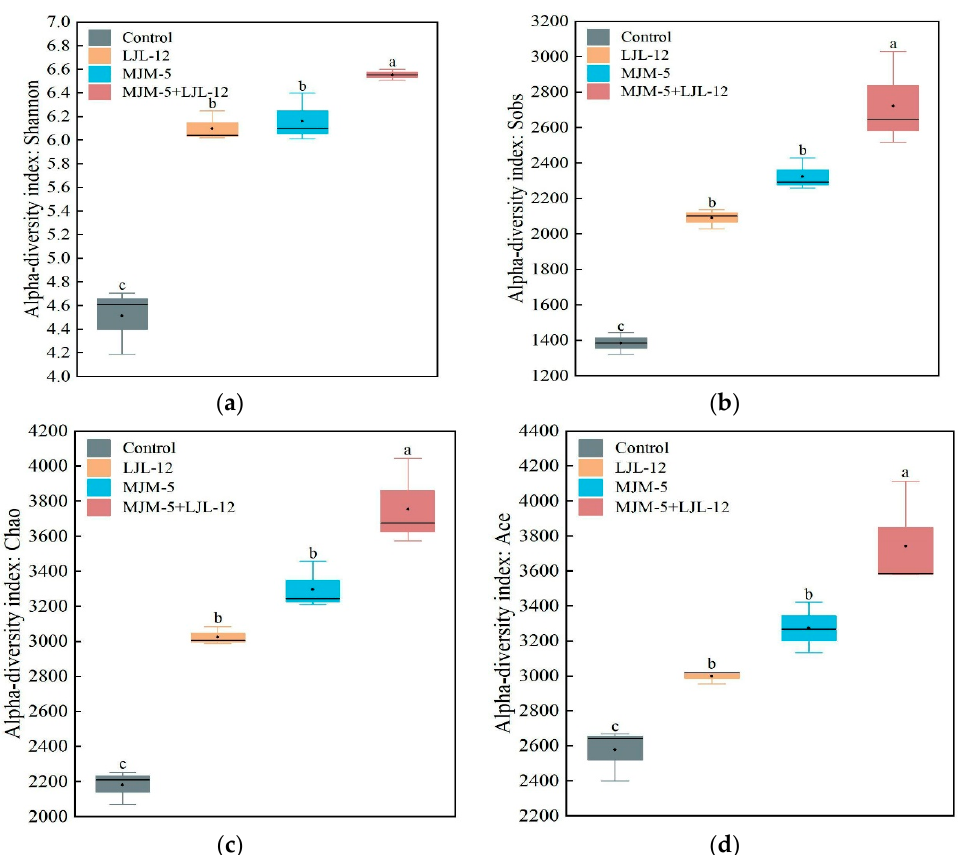
Figure 3. Alpha-diversity indices of soil bacterial community in the rhizosphere of alfalfa under Control, LJL-12, MJM-5, and MJM-5+LJL-12 treatments: ( a ) Shannon; ( b ) Sobs; ( c ) Chao; ( d ) Ace. Different lowercase letters indicate statistically significant differences among the treatments ( p < 0.05).